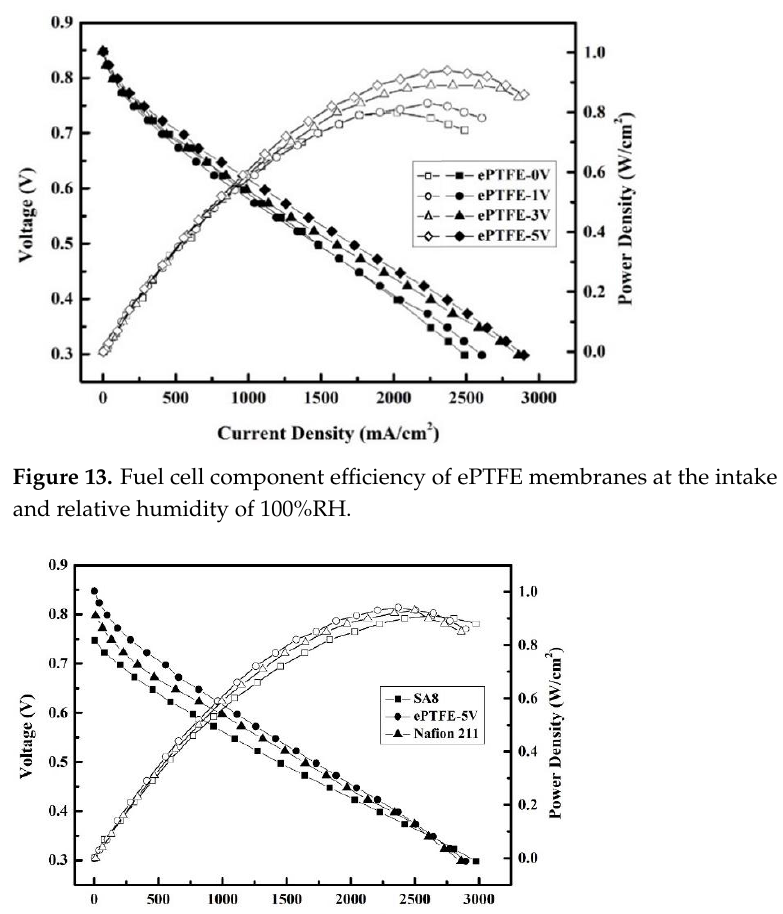
Figure 13. Fuel cell component efficiency of ePTFE membranes at the intake temperature of 80 °C and relative humidity of 100%RH.